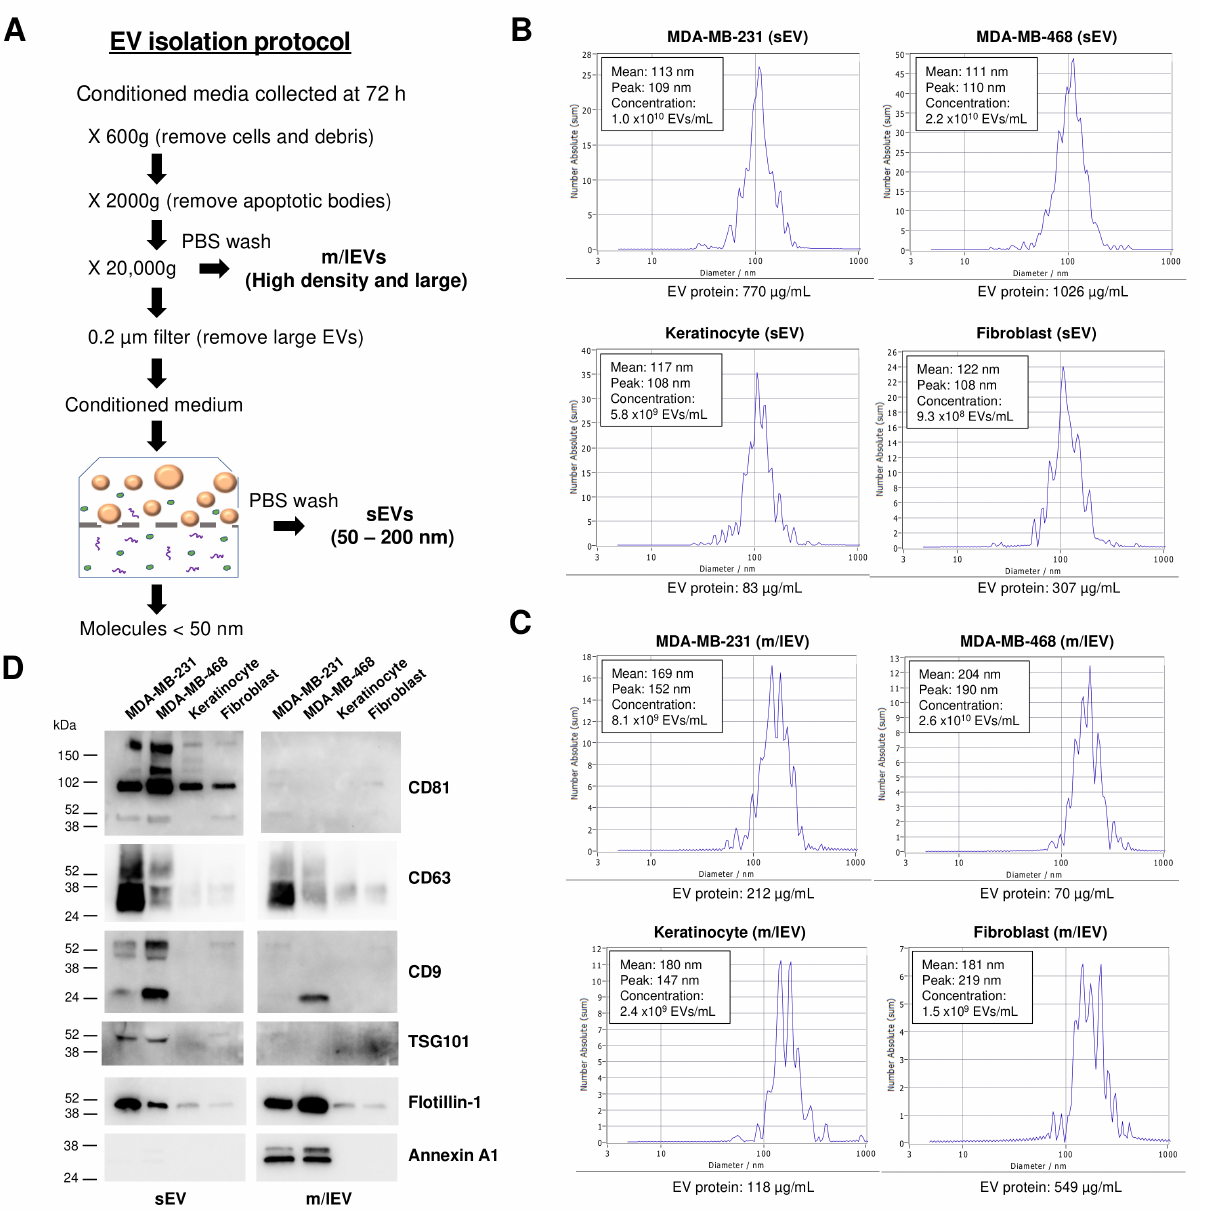
Figure 1. EV subtype-specific enrichment and characterization. ( A ) Schematic depiction of the isolation protocol for small EVs (sEVs) and medium/large EVs (m/lEVs). ( B , C ) Size distributions and protein concentrations of sEV- and m/lEV-enriched fractions derived from cancer (MDA-MB-231, MDA-MB-468) and non-cancerous cells (keratinocyte, fibroblast) measured by nanoparticle tracking analysis (NTA) and Bradford assay, respectively. ( D ) Western blot analysis of the EV marker proteins, CD81, CD63, CD9, TSG101, flotillin-1, and annexin A1 in sEV- and m/lEV-enriched fractions from each cell